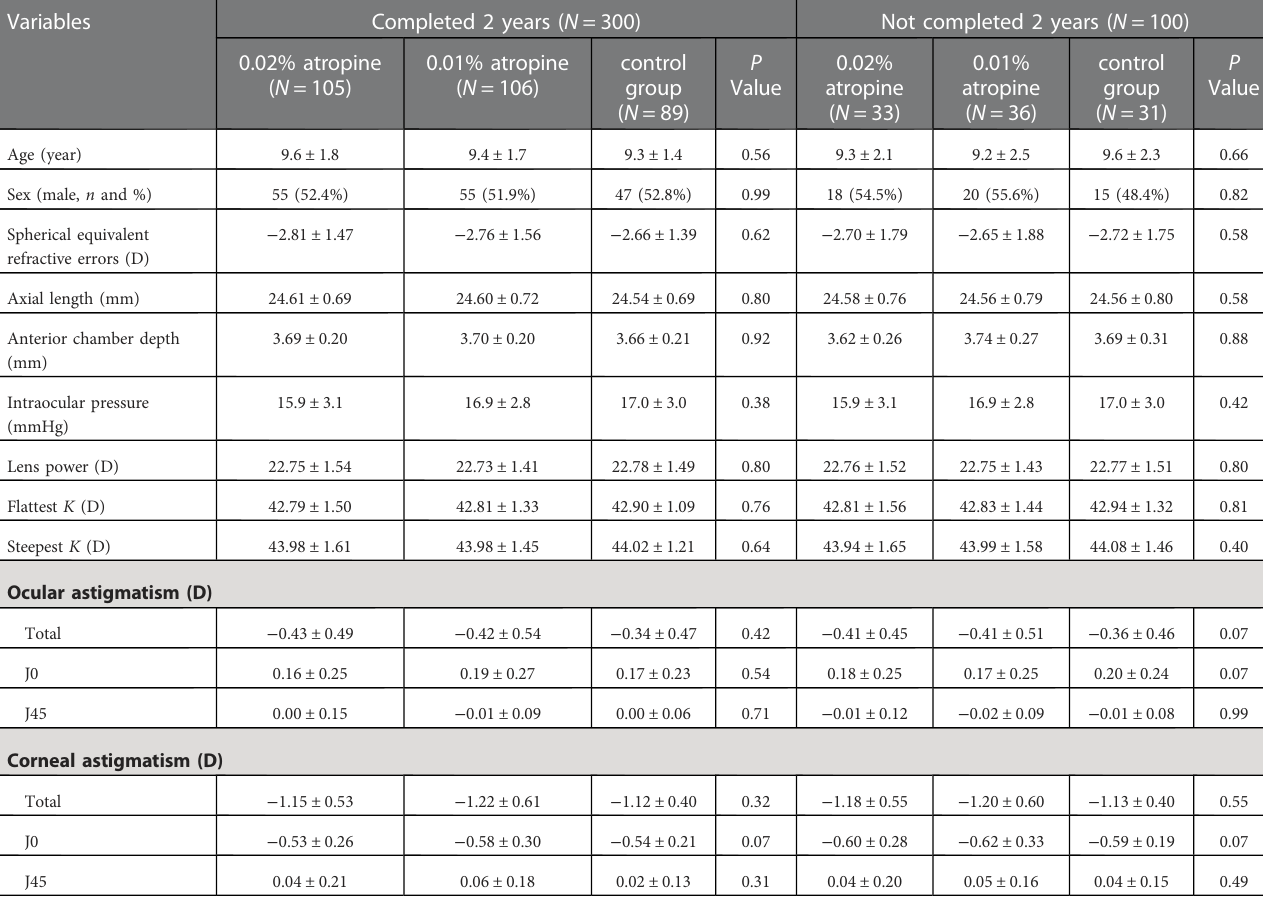
TABLE 1 Baseline characteristics of study participants who completed 2 years vs. those who have not completed 2 years.